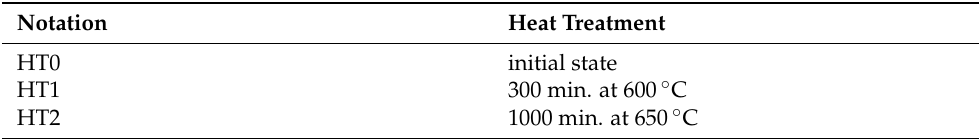
Table 2. Heat treatment time and temperature of the